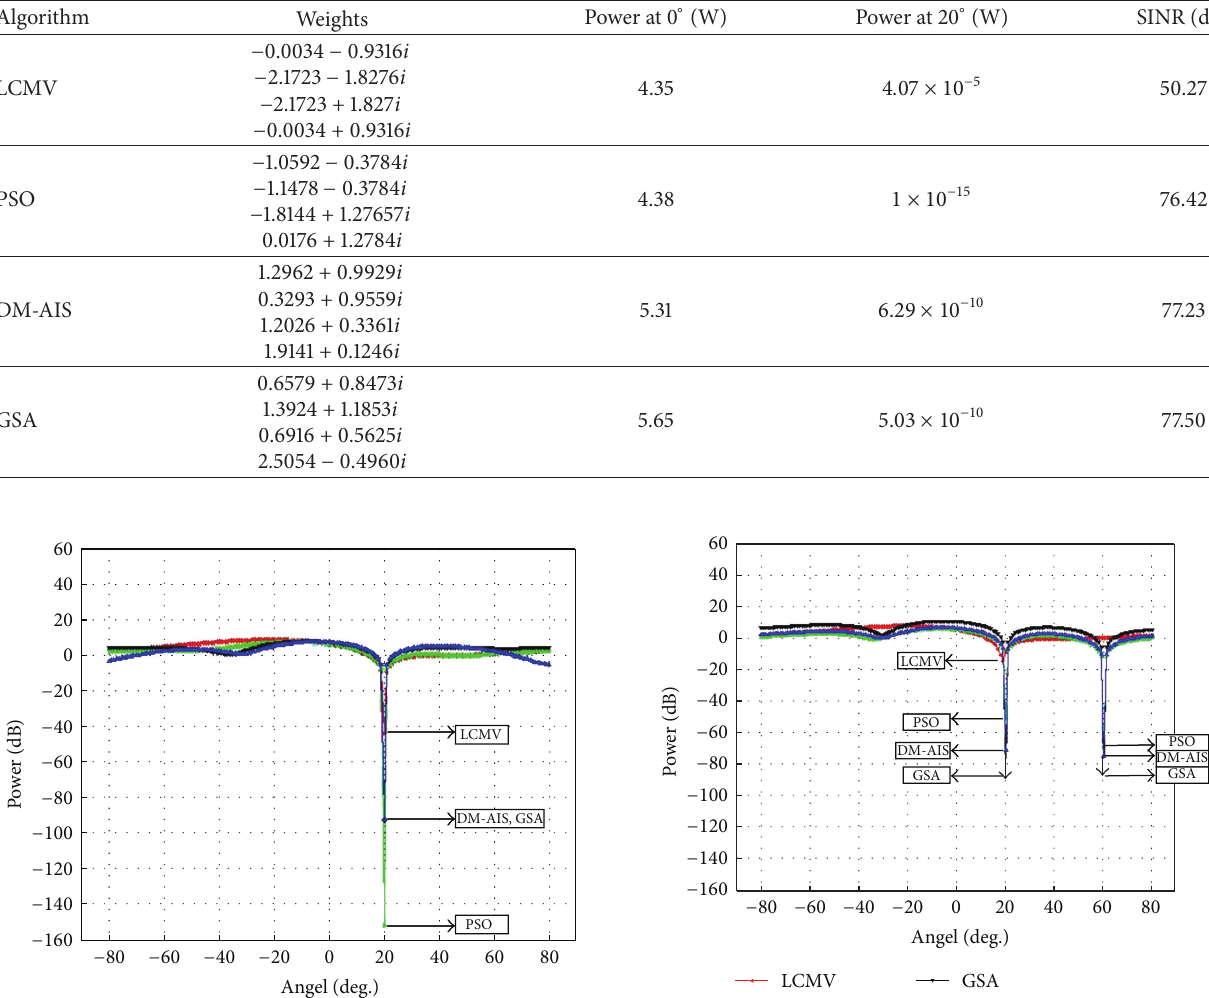
Table 2: Comparison of weight vectors, power values, and SINR calculation for conventional LCMV, PSO-LCMV, DM-AIS-LCMV, and GSA-LCMV for user at 0 ∘ with interference at 20 ∘ by using 4 elements.